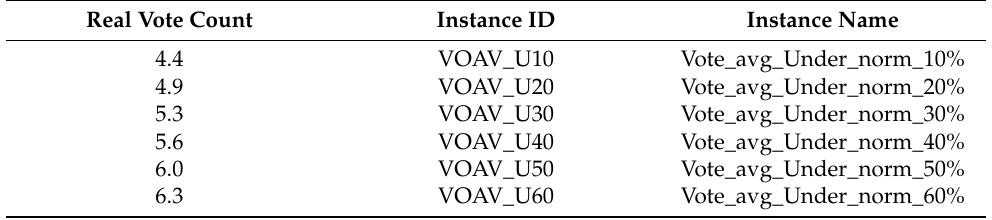
Table A7. Categorization criteria of “Vote_Count” class in the